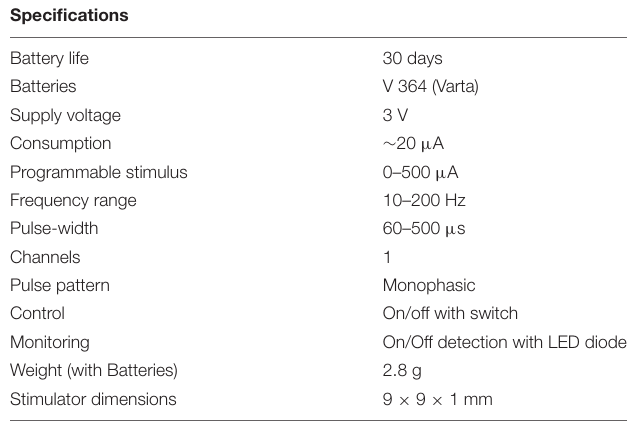
TABLE 2 | Technical specification of the